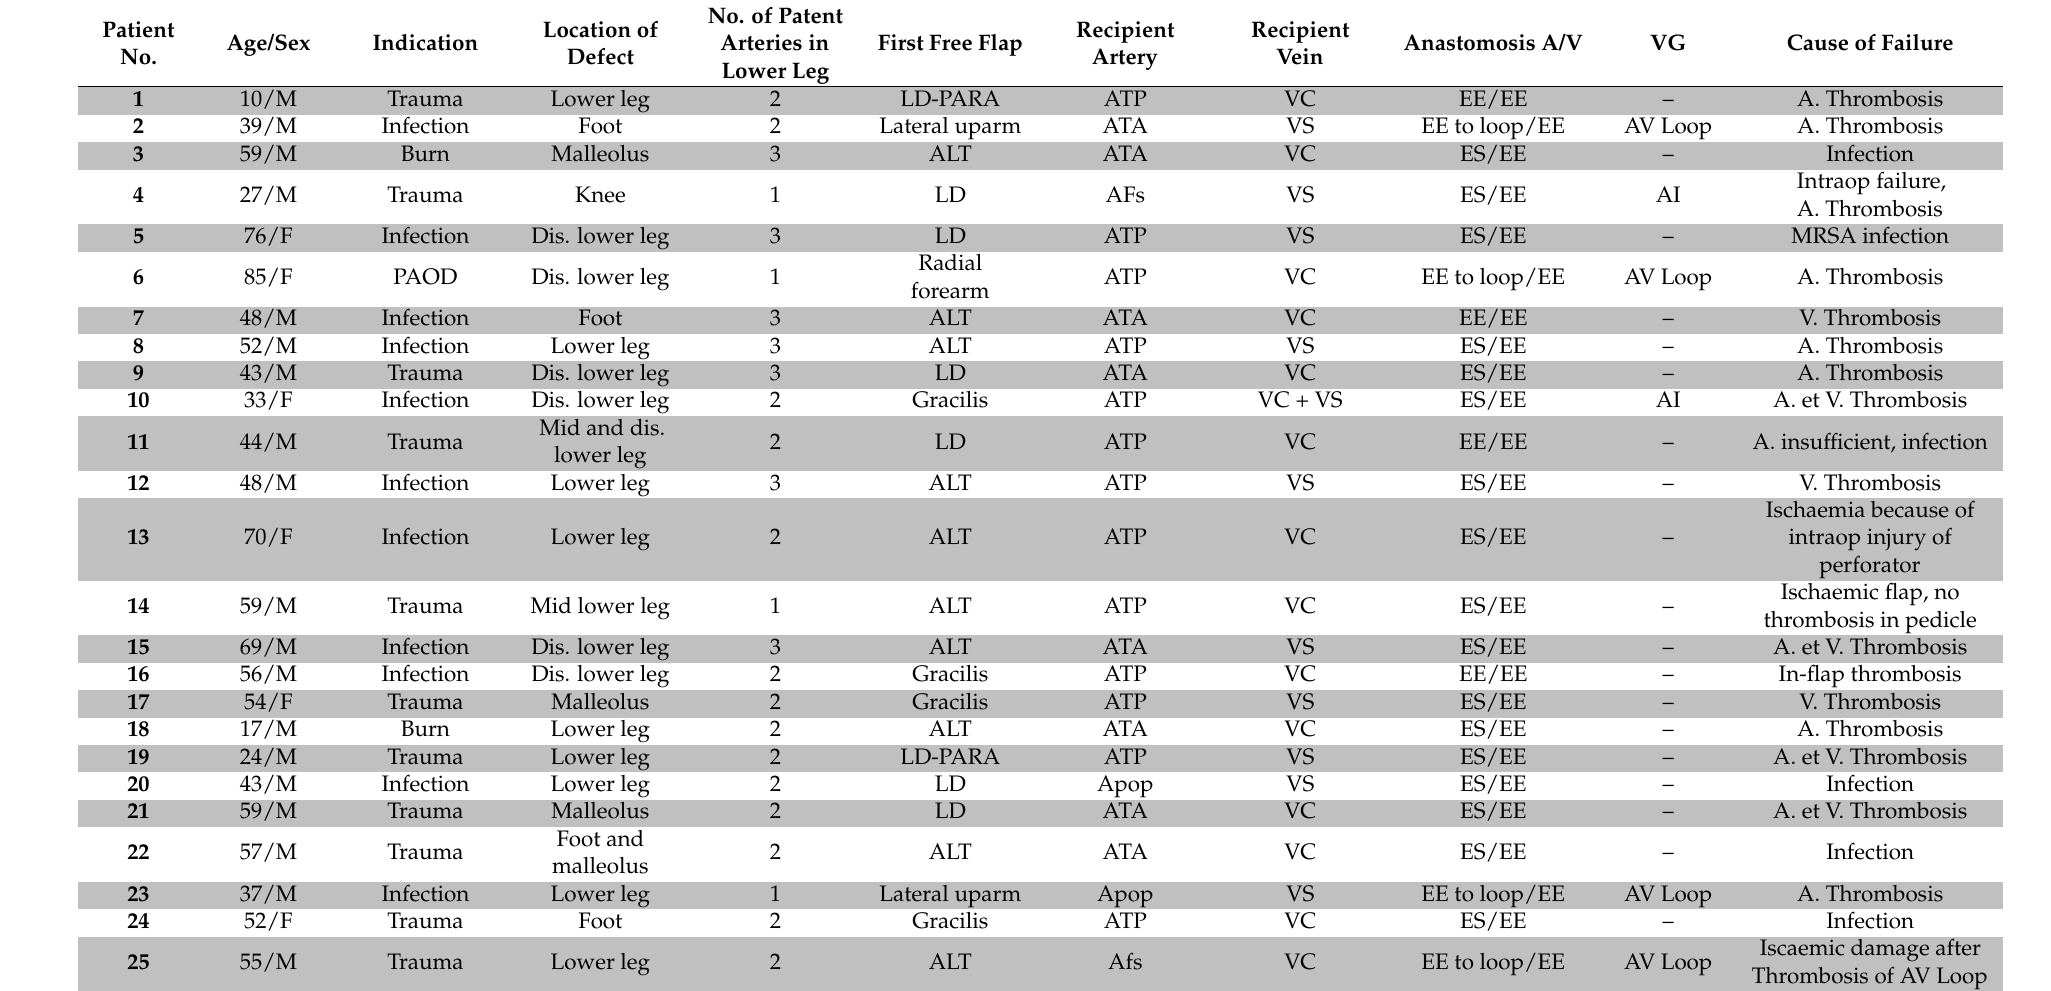
Table 1. Patient characteristics and data on the failed primary microsurgical